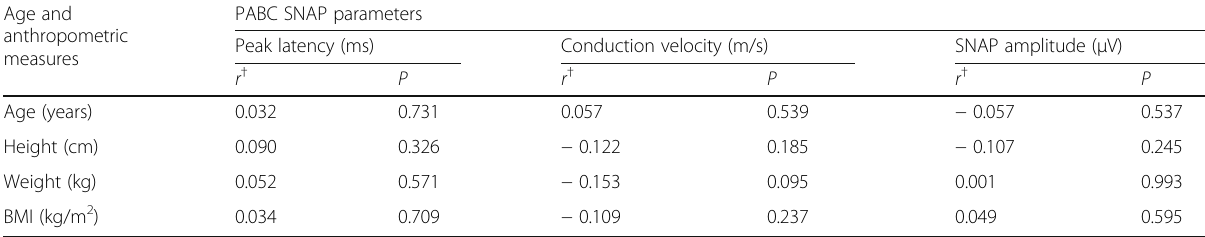
Table 5 Correlation between participants ’ age and anthropometric measures with different posterior antebrachial cutaneous sensory nerve action potential parameters (120 upper limbs from 60 apparently healthy subjects) Age and anthropometric